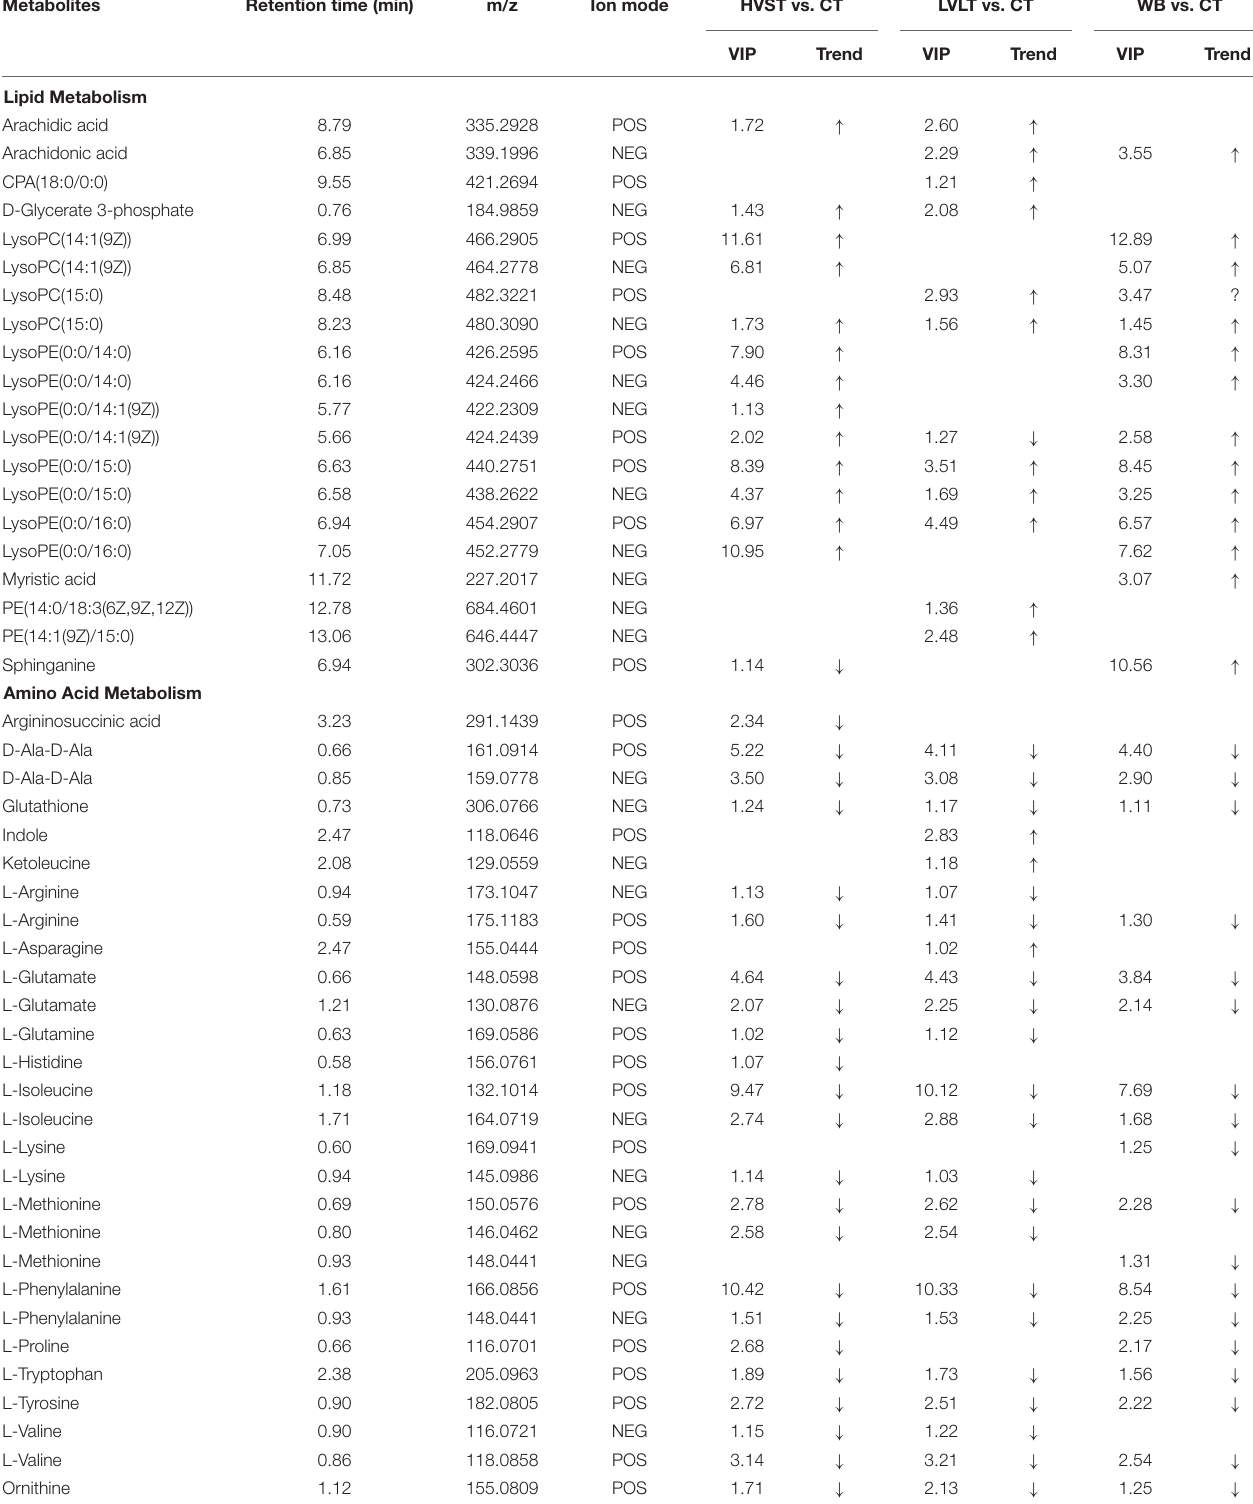
TABLE 2 | List of differential metabolites from HVST vs. CT, LVLT vs. CT, and WB vs. CT treated E. coli O157:H7 cells. Metabolites Retention time (min) m/z Ion mode HVST vs. CT LVLT vs. CT WB vs. CT VIP Trend VIP Trend VIP